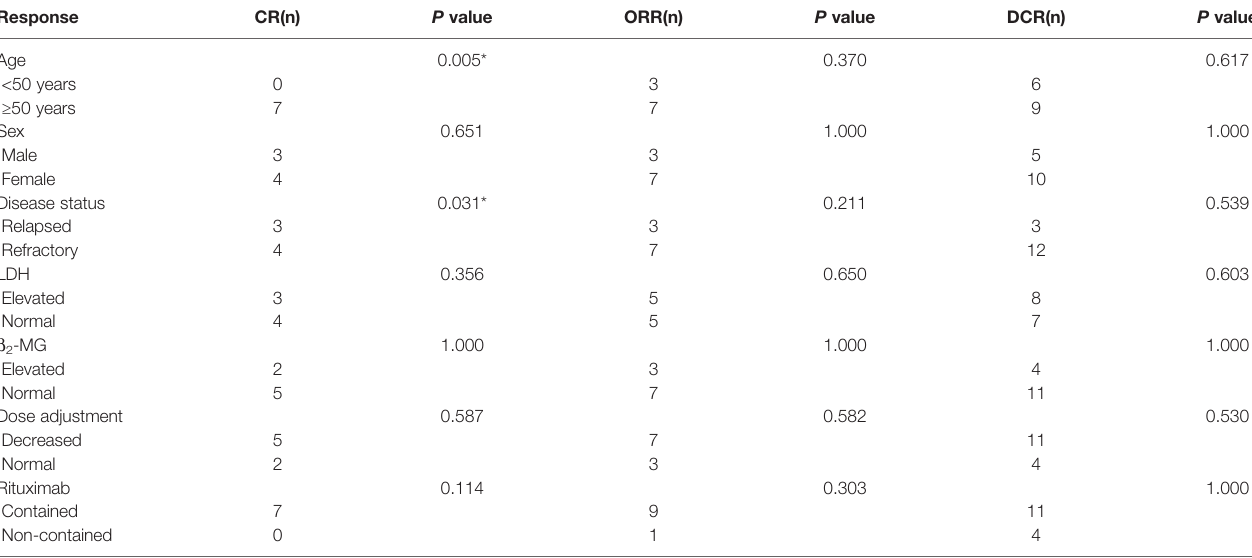
TABLE 3 | Responses to